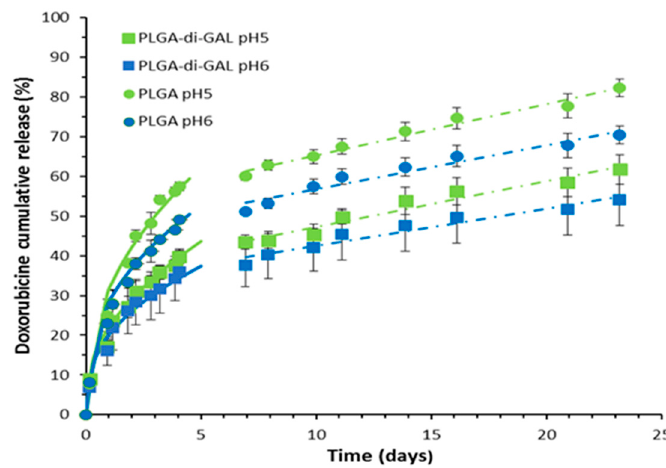
Figure 6. In vitro release of doxorubicin from PLGA–di-GAL NP and PLGA-NP at pH 5 and 6. Data are expressed as the mean ± standard deviation ( n = 3). Solid lines obtained by the Korsmeyer Peppas model (Equation (1)). Dashed lines obtained by zero order kinetic model.